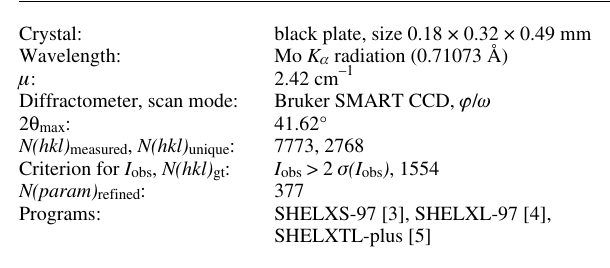
Table 1. Data collection and handling.